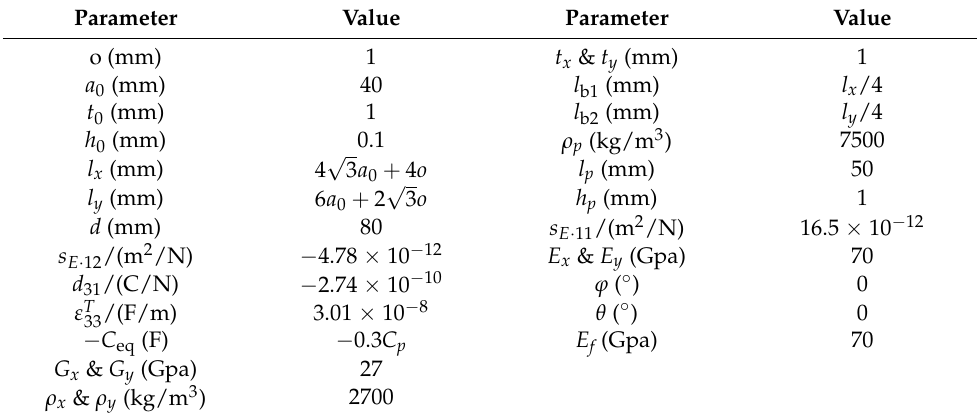
Table 1. Properties of one periodic